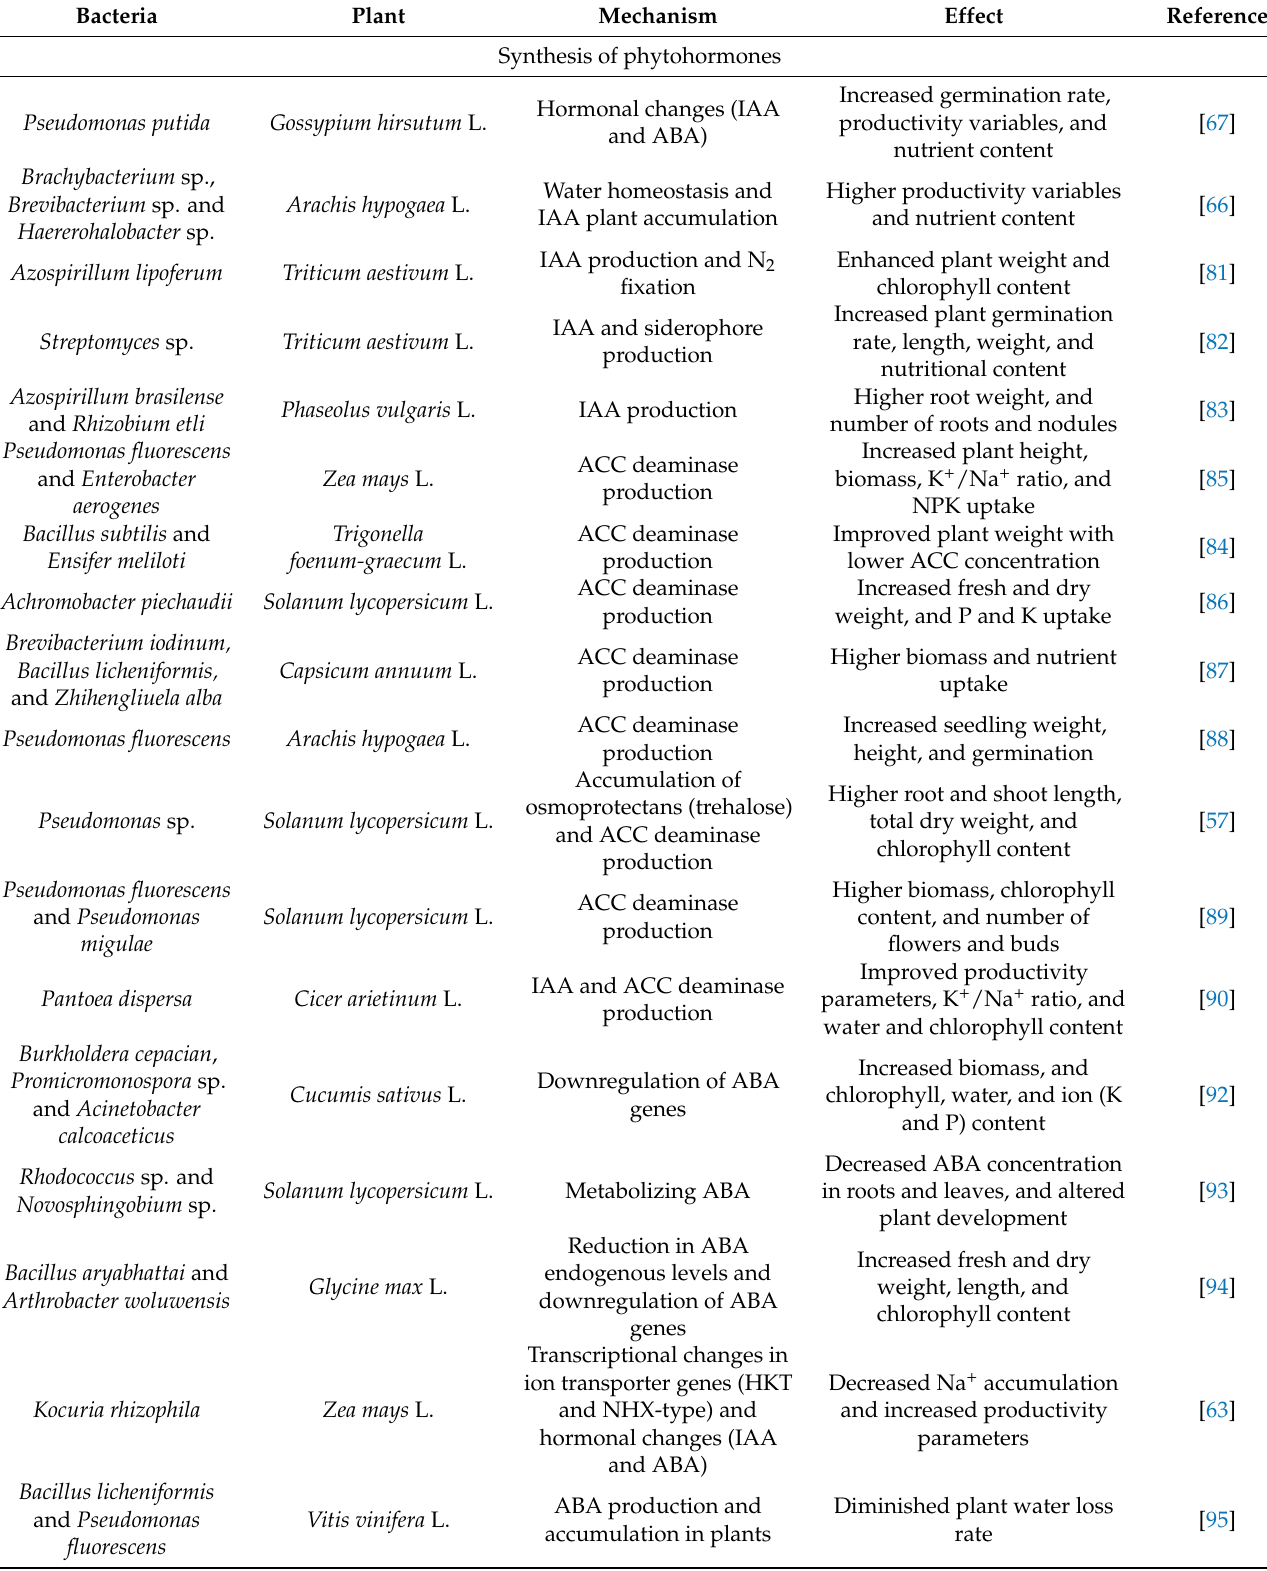
Table 2. PGPB producing molecules involved in tolerance to salinity